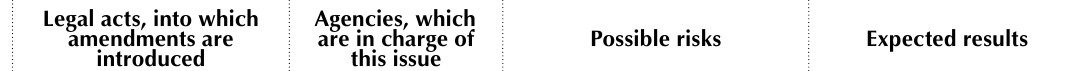
Table 4. Proposed measures of tax stimulation for subjects of the tourist market in the context